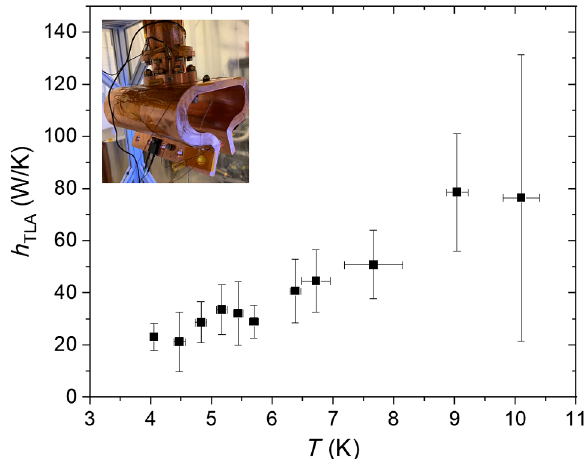
FIG. 18. Thermal conductance of the Cu TLA shown in Fig. 17 as a function of temperature. The inset shows a picture of the TLA mounted to stage 2 of the CCR at Jefferson